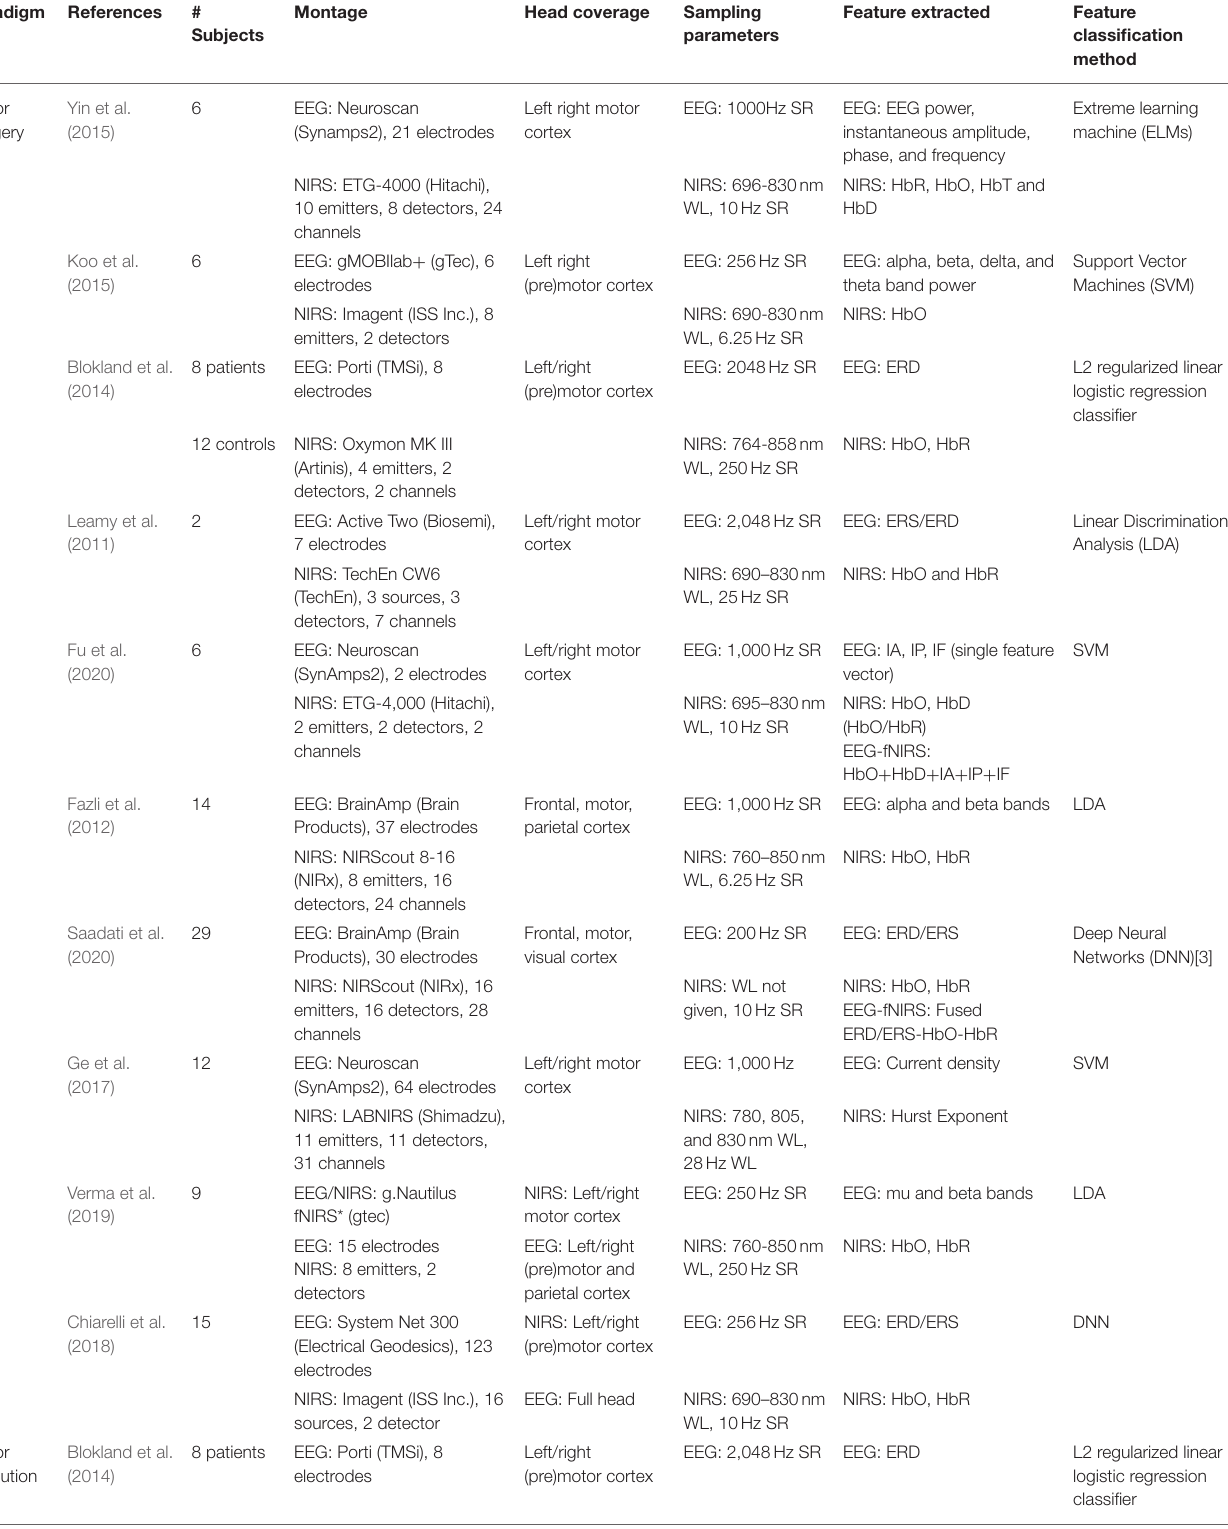
TABLE 1 | Target methodological details of the studies included in the